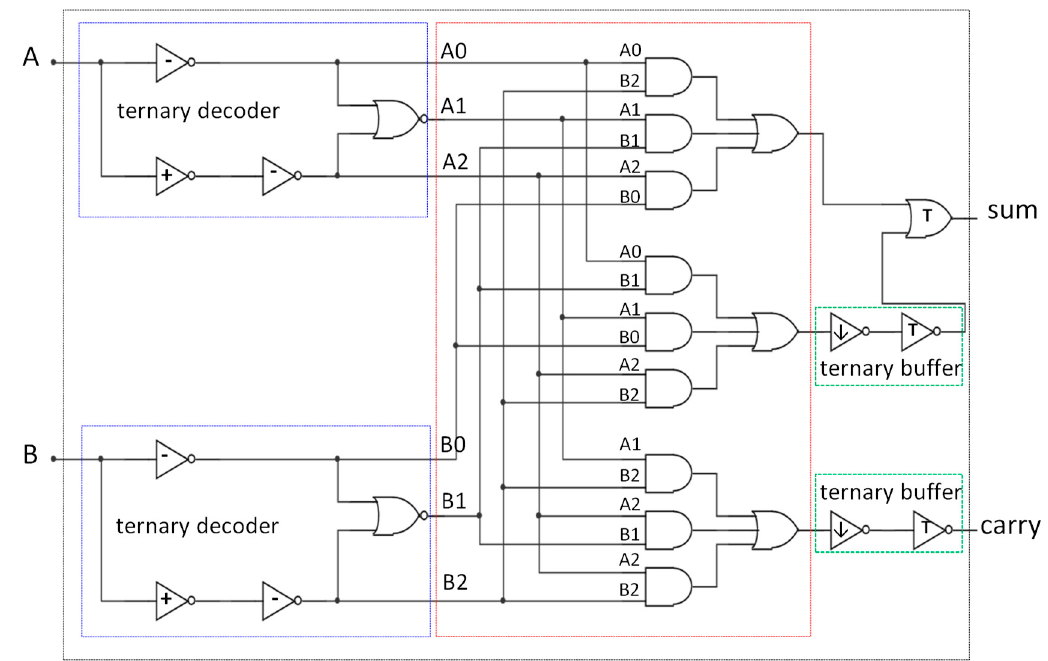
Figure 5. Conventional design of ternary half-adder. The ternary input ( A , B ) signals are firstly decoded by the ternary decoder (the two blue dashed box regions). Then the signals are transferred to the logic computation unit (red dashed box region). Finally the calculated results are re-transferred to be a ternary signal (green dashed box region) as output. Note: The unlabeled logic gates represent the normal binary logic gate.